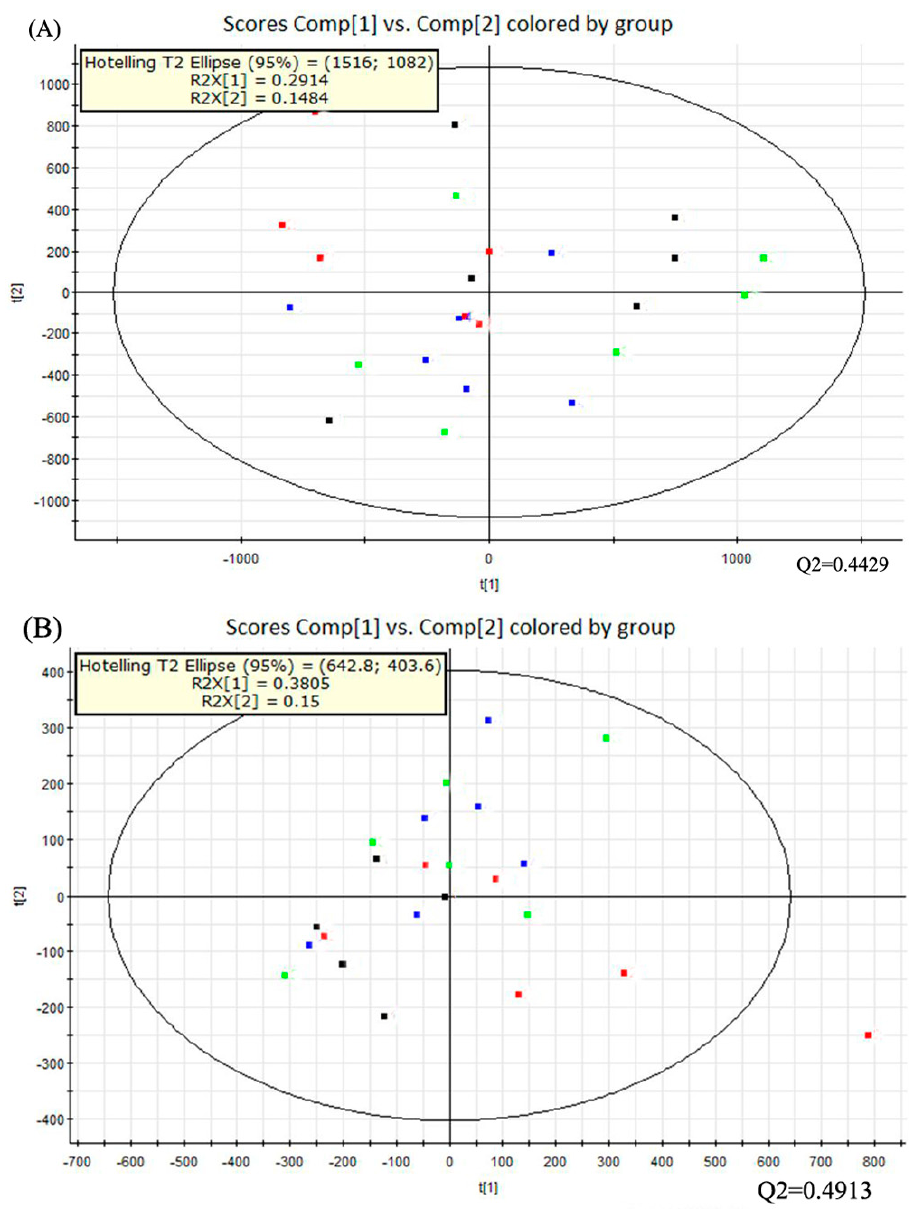
Figure 3. PCA score plots of the four tested groups from UPLC-Q-TOF-MS profiling data. The PCA score plot showed that different liver samples were distributed into different areas; all samples were in the Hostelling T2 ellipse. ( A ) PCA score plot from positive ion mode; ( B ) PCA score plot from negative ion mode. PCA, Principal component analysis; UPLC-Q-TOF-MS, Ultra-performance liquid chromatography- quadrupole-time-of-flight-mass spectrometry. ( : Dextrose control; : Alcohol control; : 0.04%NTs; : 0.16%NTs).